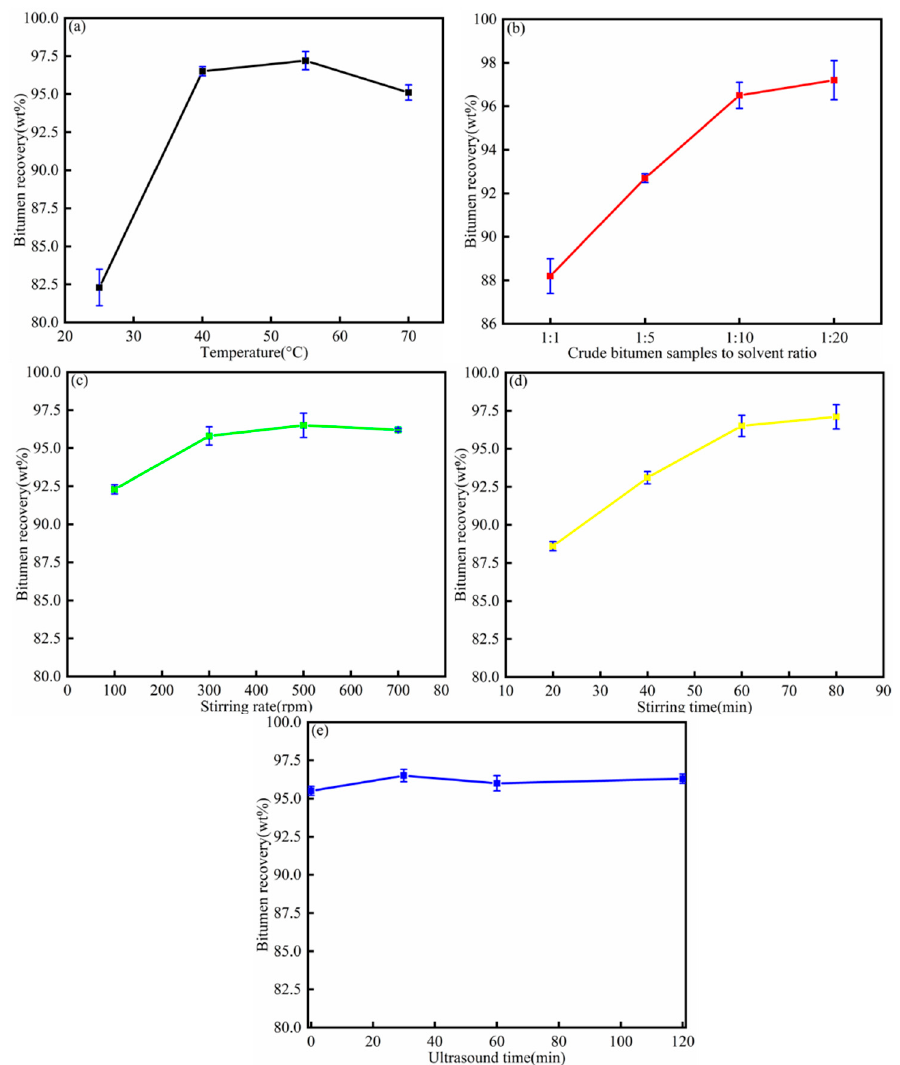
Figure 3. Influence of ( a ) temperature (black line), ( b ) crude bitumen sample to solvent ratio (red line), ( c ) stirring rate (green line), ( d ) stirring time (yellow line), and ( e ) ultrasound time (blue line) on the bitumen recovery from crude bitumen samples.